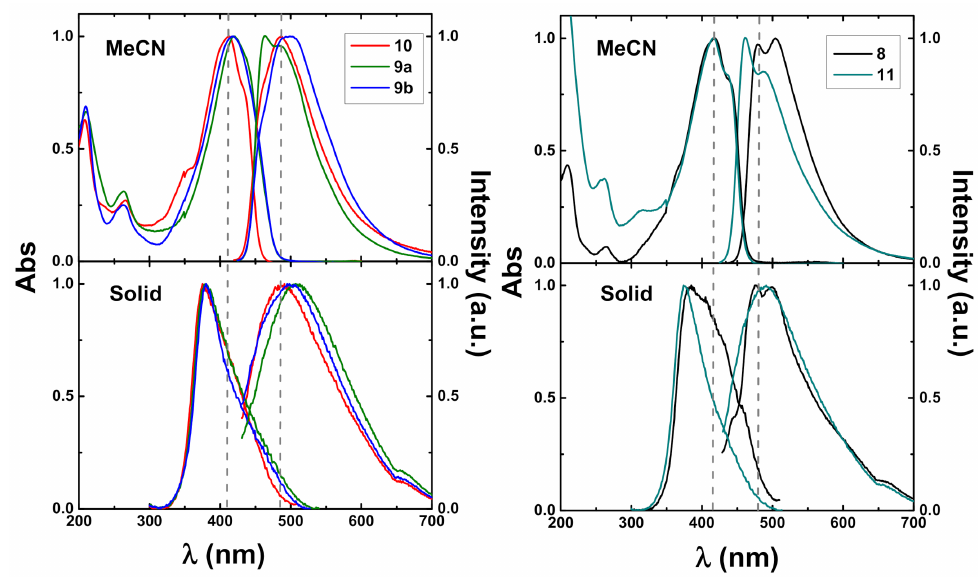
Figure 2. Normalized absorption and fluorescence emission spectra for compounds 8 – 11 in acetoni- trile solution and in the solid state (adsorbed in TiO 2 films) at